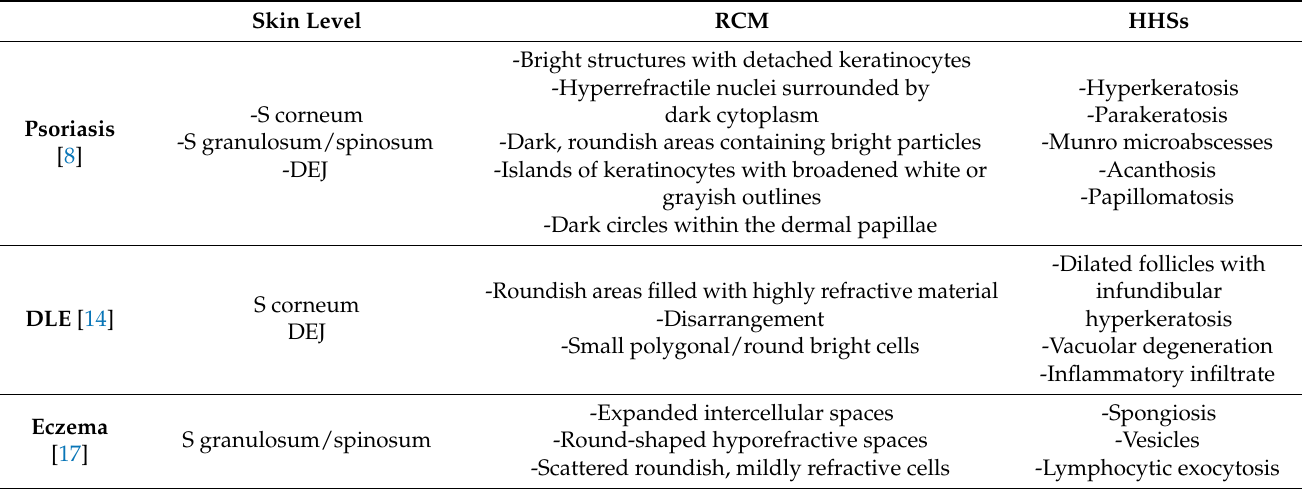
Table 1. Summary of the correlation between RCM and HHS results in inflammatory skin